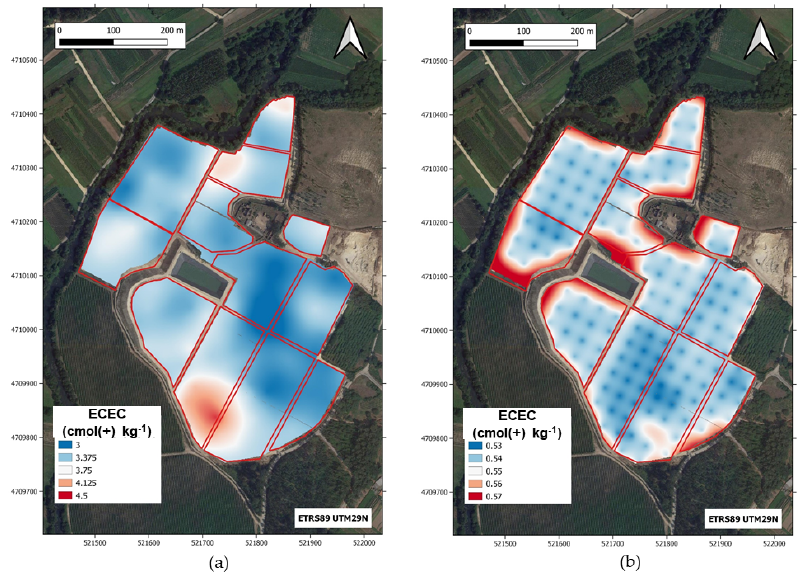
Figure 7. Estimation ( a ) and error ( b ) maps of effective cation exchange capacity (ECEC) over the experimental vineyard generated by ordinary kriging.